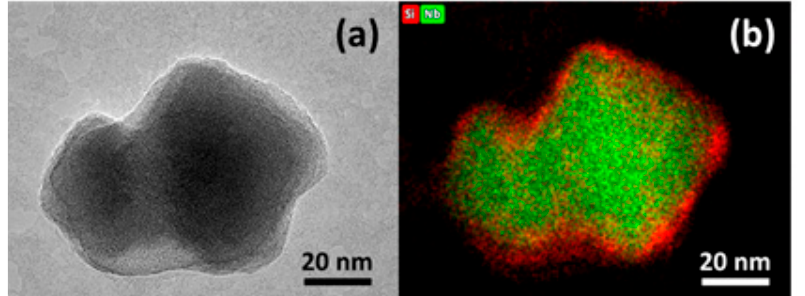
Figure 5. Representative STEM images of LNO@Talys NPs: ( a ) bright field image and ( b ) EDX ele- mental mapping (Si and Nb) of LNO@Talys . elemental mapping (Si and Nb) of LNO@Talys